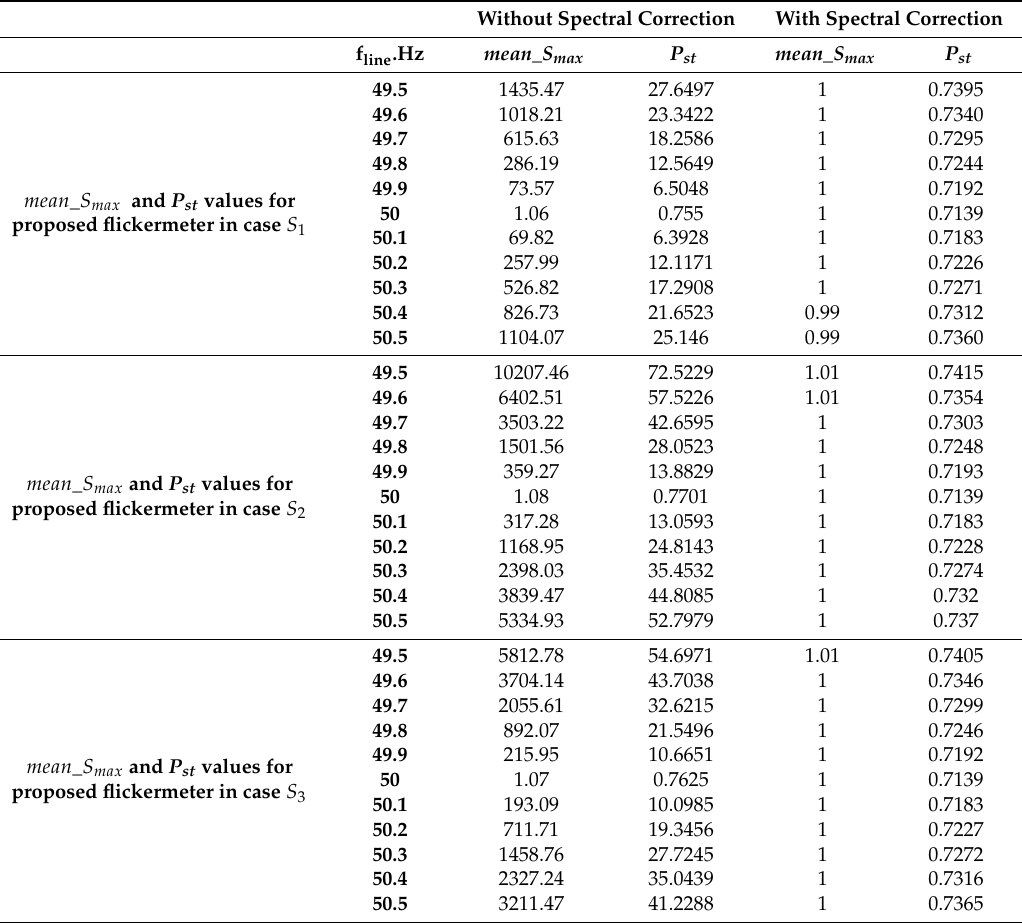
Table 2. mean _ S max and P st values for proposed flickermeter with 40 Hz interharmonic. Without Spectral Correction With Spectral Correction f line .Hz mean _ S max P st mean _ S max P